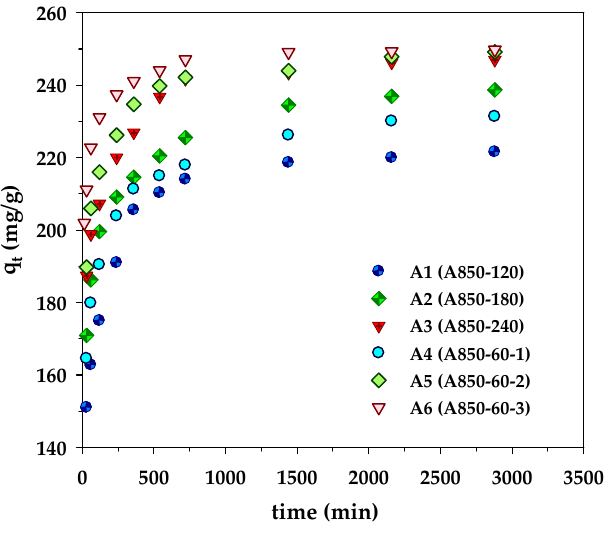
Figure 2. Kinetics of methylene blue adsorption on the prepared microporous- and mesoporous- activated carbons from longan fruit seed. Table 5. Kinetic parameters of various adsorption kinetic models for MB adsorption by longan seed-activated carbons.